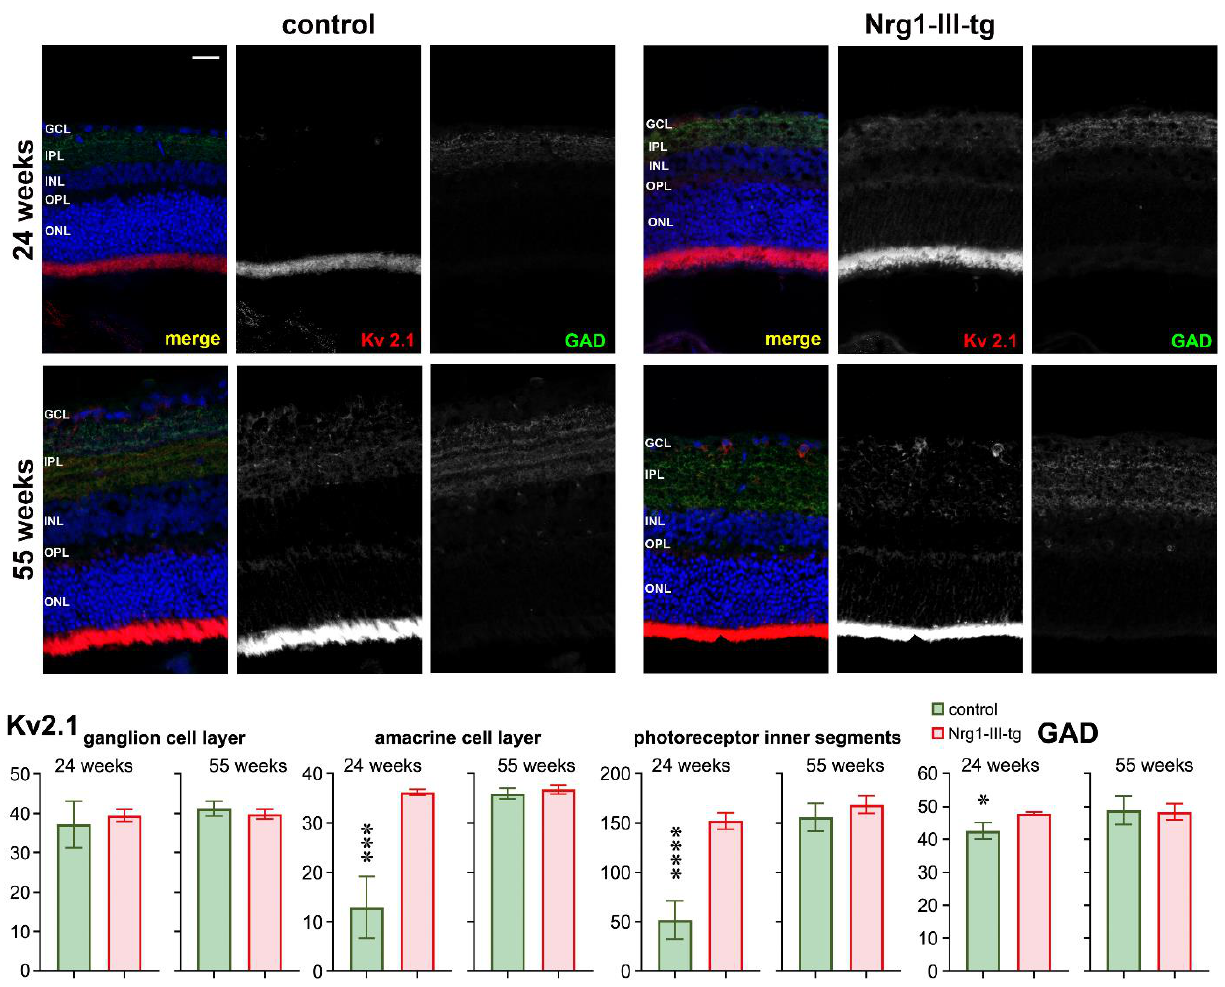
Figure 6. Immunohistochemical staining against Kv2.1 and GAD. Kv2.1 (red) and GAD (green) in frozen sections of the retina of the mouse eye at 24 weeks and 55 weeks of control and Nrg1-III-tg as indicated. The cell nuclei were stained with DAPI (blue); GCL-ganglion cell layer; IPL-inner plexiform layer; INL-inner nuclear layer; OPL-outer plexiform layer; ONL-outer nuclear layer. Scale bar: 50 µ m. * p < 0.05, *** p < 0.001, **** p <